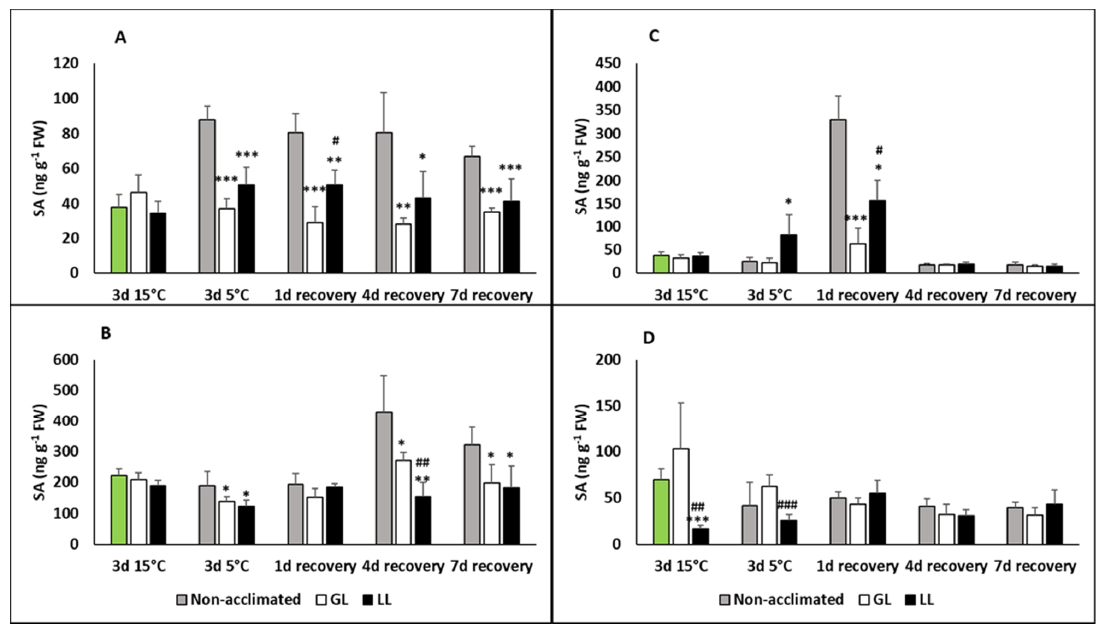
Figure 1. Changes in the salicylic acid (SA) contents during cold acclimation (15/13 °C), chilling (5 °C) and recovery in the leaves and roots of young maize plans: control plants (22/20 °C, 387 µmol m −2 s −1 ). Light intensities during hardening: growth light (GL): 387 µmol m −2 s −1 ; low light (LL): 107 µmol m −2 s −1 . *, **, *** significant differences compared to the control plants on the same day at the p < 0.05, 0.01 and 0.001 levels, respectively. # , ## , ### significant differences compared to the GL plants on the same day at the p < 0.05, 0.01 and 0.001 levels, respectively. ( A : free SA in the leaves; B : bound SA in the leaves; C : free SA in the roots; D : bound SA in the roots).